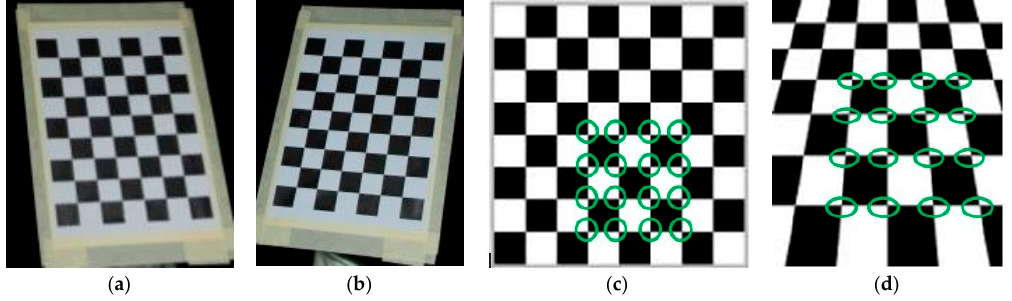
Figure 1. Stereo camera calibration checkerboard, ( a ) left (L) images. ( b ) right (R) images; ( c , d ) change in the pattern related to the perspective.